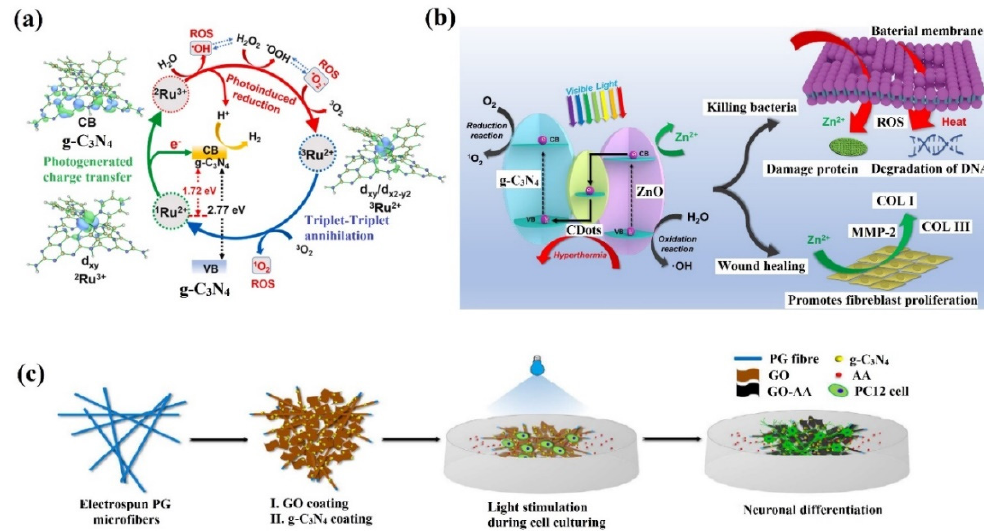
Figure 5. ( a ) The photocatalytic 1 O 2 generation mechanism of Ru-g-C 3 N 4 in the presence of H 2 O 2 or H 2 O. The superscripts on the Ru ions denote the ground state Ru 2+ , the triplet state Ru 2+ , and the radical, cationic species Ru 3+ ; ( b ) schematic representation of ZnO/CDots/g-C 3 N 4 Z-schemes for photo-assisted bacteria inactivation; ( c ) diagrammatic illustration of the growth of neural PC12 cells on g-C 3 N 4 /graphene composite fibers on exposure to visible light. Reproduced with permission from [63–65] with license numbers 5161471258951 and 5161480119676. Copyright American Chemical